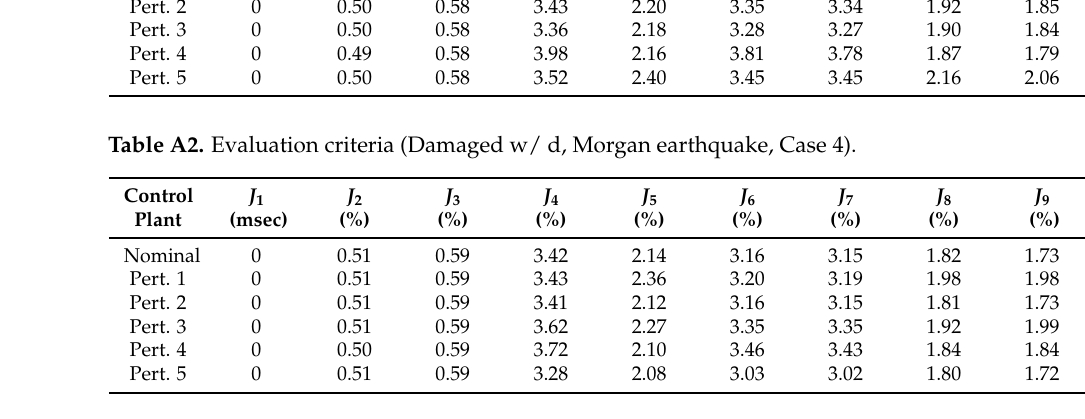
Table A3. Evaluation criteria (Damaged w/ d, Chirp excitation, Case